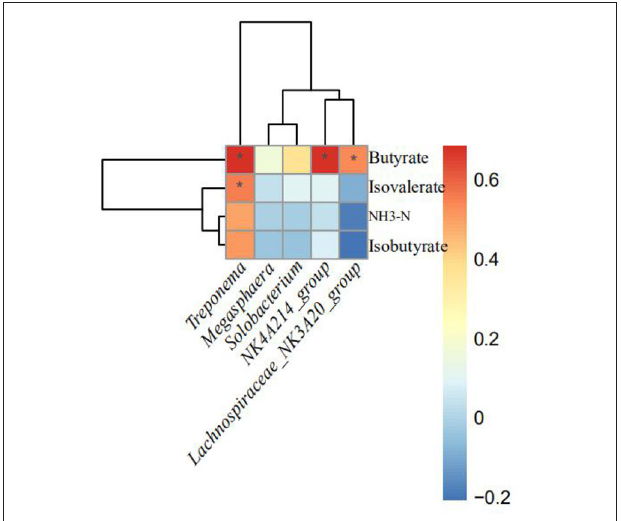
FIGURE 3 | Correlation between the altered rumen bacteria (genus) and rumen fermentation indices. Significant differences are indicated as * p < 0.1. NH 3 -N, ammonia